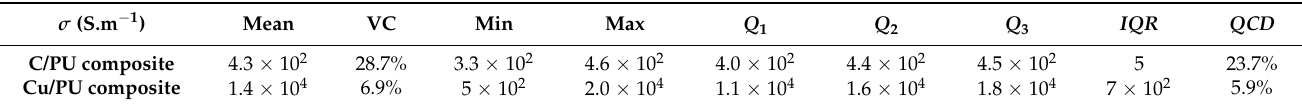
Table 9. Statistical data related to electrical properties of the conductive coatings. All parameters have the same unit of electrical conductivity σ QCD , which are in